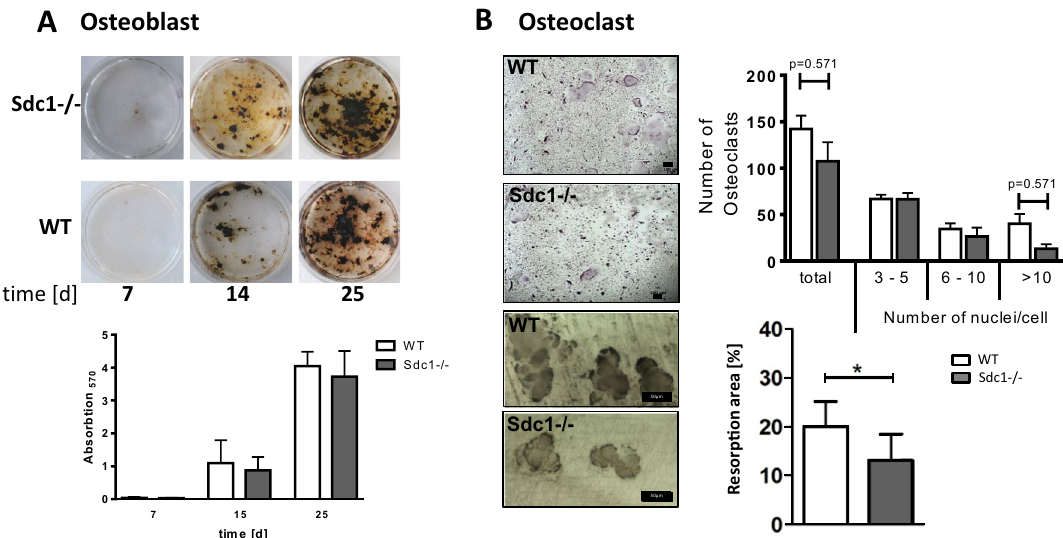
Figure 2. Differentiation and functionality of osteoblasts and osteoclasts dependent on Syndecan-1. ( A ) Primary osteoblast precursors (WT, Sdc1−/−) were isolated from calvariae of newborn mice, seeded in DM-Medium (see Table 1) and cultured for up to 25 days. Mineralization of the extracellular matrix was visualized by von Kossa staining and quantified photometrically after alizarin red staining. ( B ) Osteoclast precursor cells were isolated from bone marrow of long bones of 4–6 week old mice (WT, Sdc1−/−) and seeded in DM-Medium supplemented with rmM-CSF and rmRANKL. Resorption was analysed using dentin chips. Cells were seeded on cleaned and sterilized dentin chips and cultured in DM-Medium supplemented with rmM-CSF and rmRANKL for up to 9 days. Differentiation of osteoclasts was determined as the development of TRAP positive, multinucleated cells. Resorption was measured as the area of resorption pits per whole area using digital imaging. Experiments were performed in triplicates, scale bars: Trap staining: 100 µm,